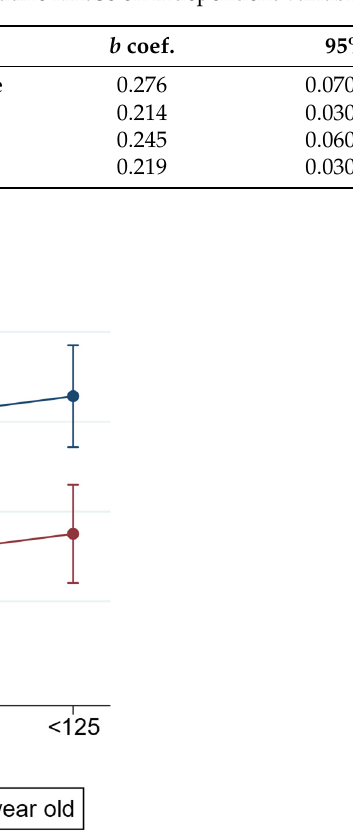
Table 6. Multivariable regression analysis of log creatine kinase on independent variables.